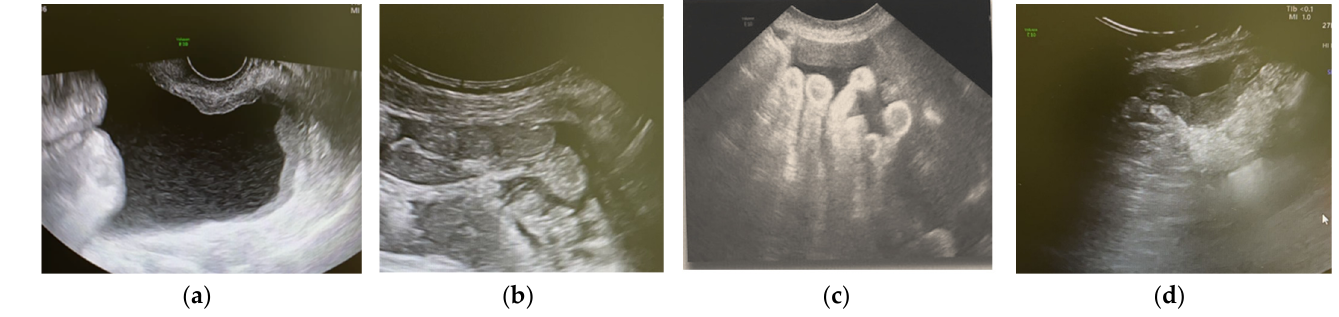
Figure 4. The US images of ascites, diffuse pelvic and abdominal parietal, and visceral carcinoma- tosis ( a ), omental cake (b), the presumed involvement of the mesenteric radix ( c ), a nodule of carcinomatosis on the descending colon ( d ) in a plausible clinical picture of inoperability.